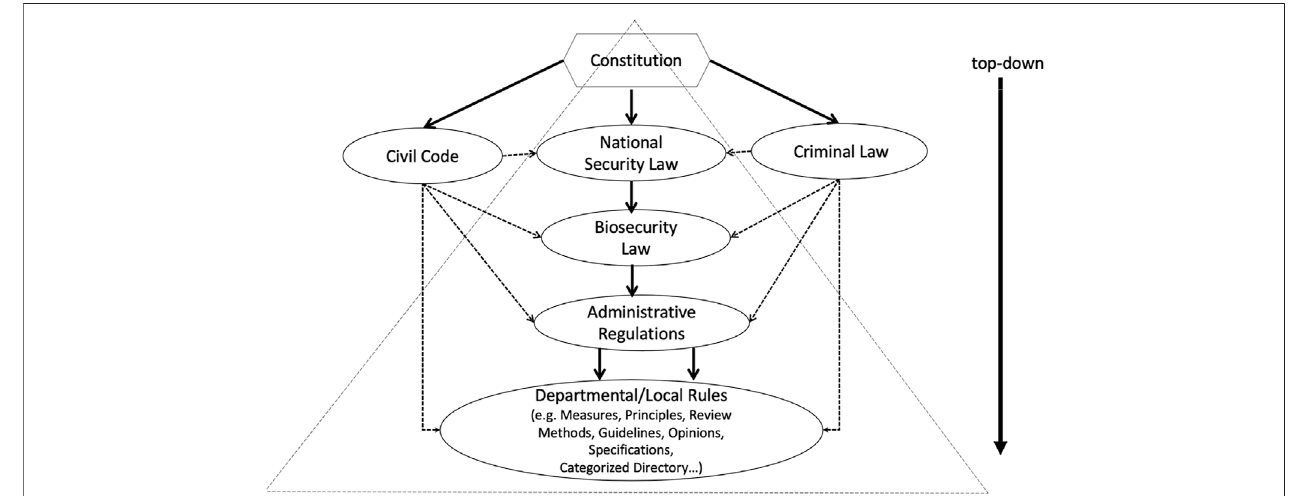
FIGURE 1 | Chinese legal framework in biosafety and